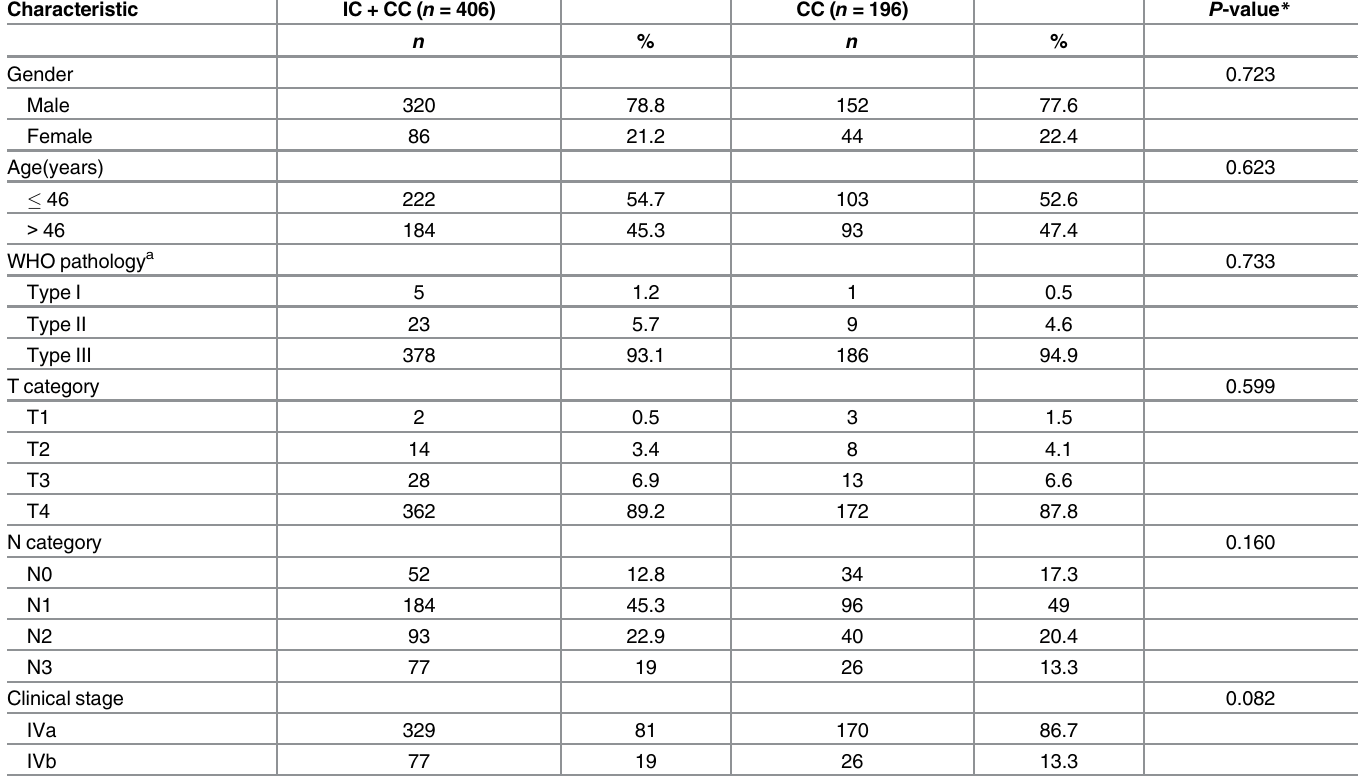
Table 1. Characteristics of the 602 patients with stage IVa-b nasopharyngeal carcinoma treated with IMRT who underwent concurrent chemother- apy with or without induction chemotherapy. Characteristic